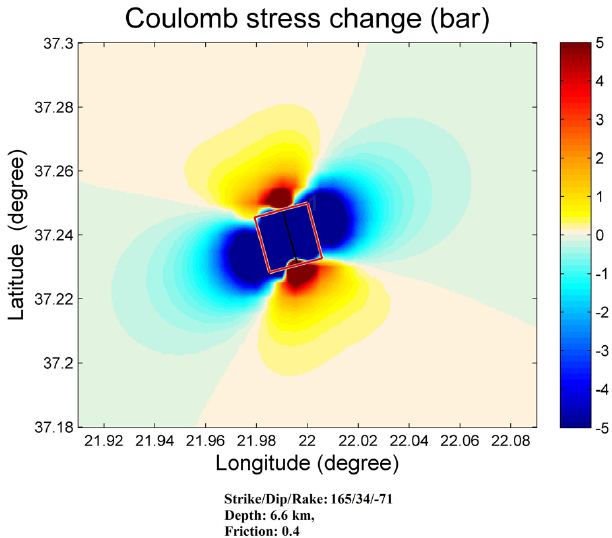
Fig. 5. Coulomb stress distribution due to the occurrence of the first largest event of the 2011 seismicity swarm on the 14 August 2011 with M W = 4.8. Red lobes indicates positive stress and blue lobes negative